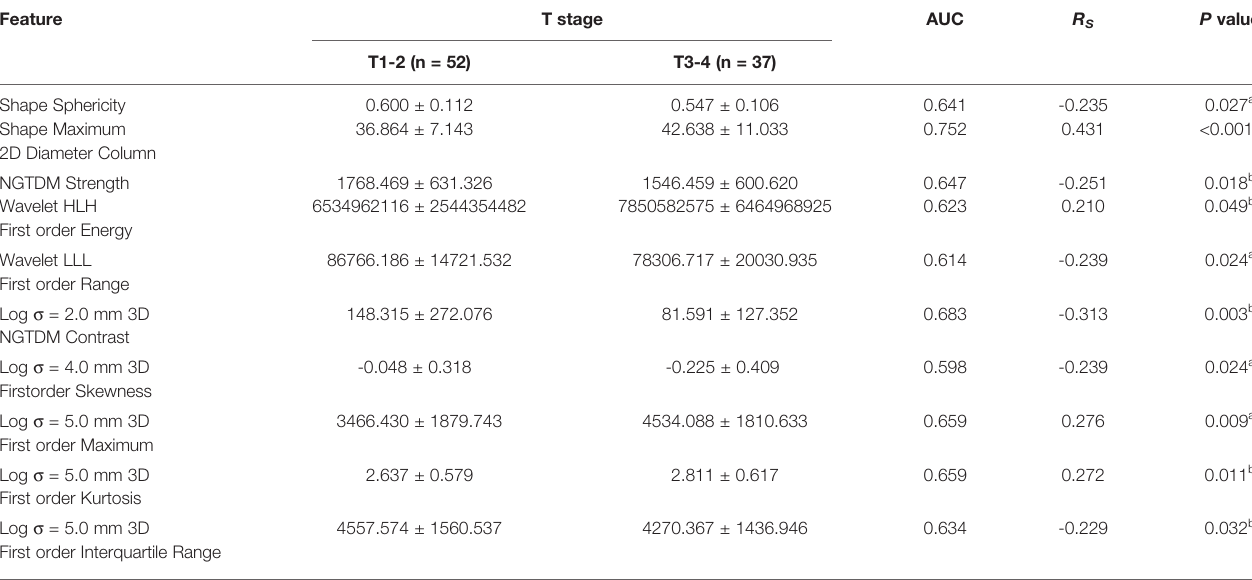
TABLE 3 | Signi fi cant features between stage T1 – 2 and T3 – 4 tumors derived from ADC maps.